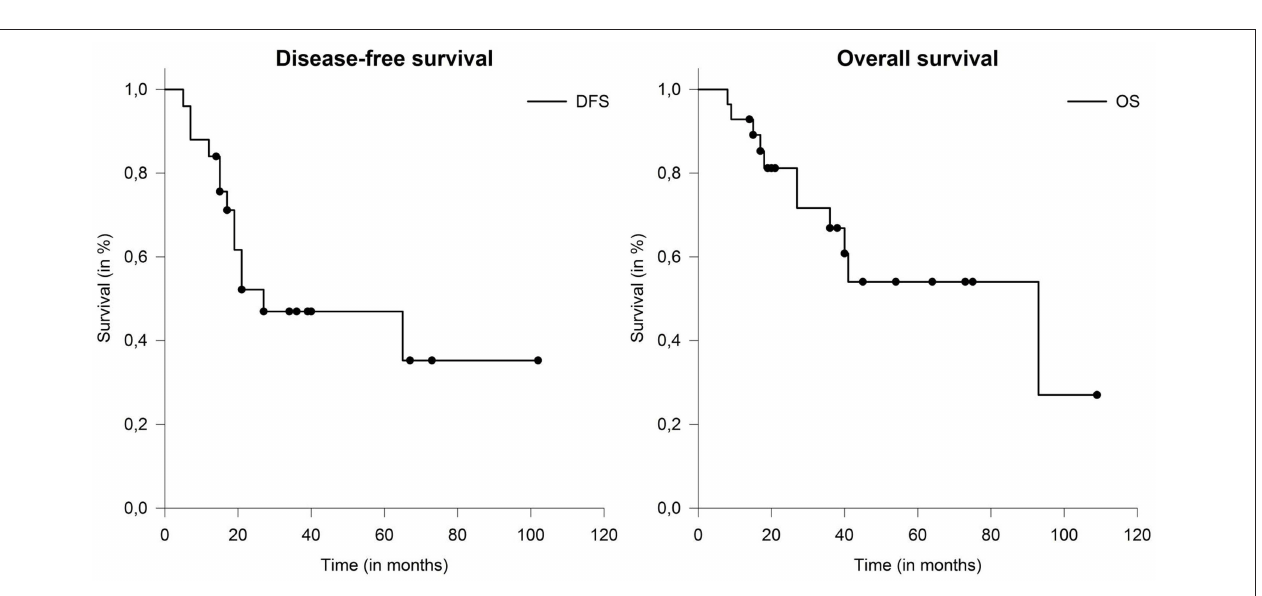
FIGURE 3 | Median disease-free survival (DFS) and overall survival (OS) in patients with salivary duct carcinoma (SDC) were 27 and 93